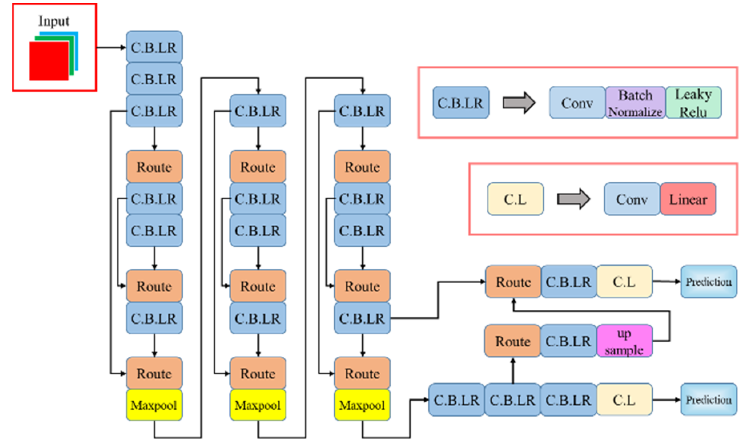
Figure 5. YOLOv4-Tiny architecture diagram.